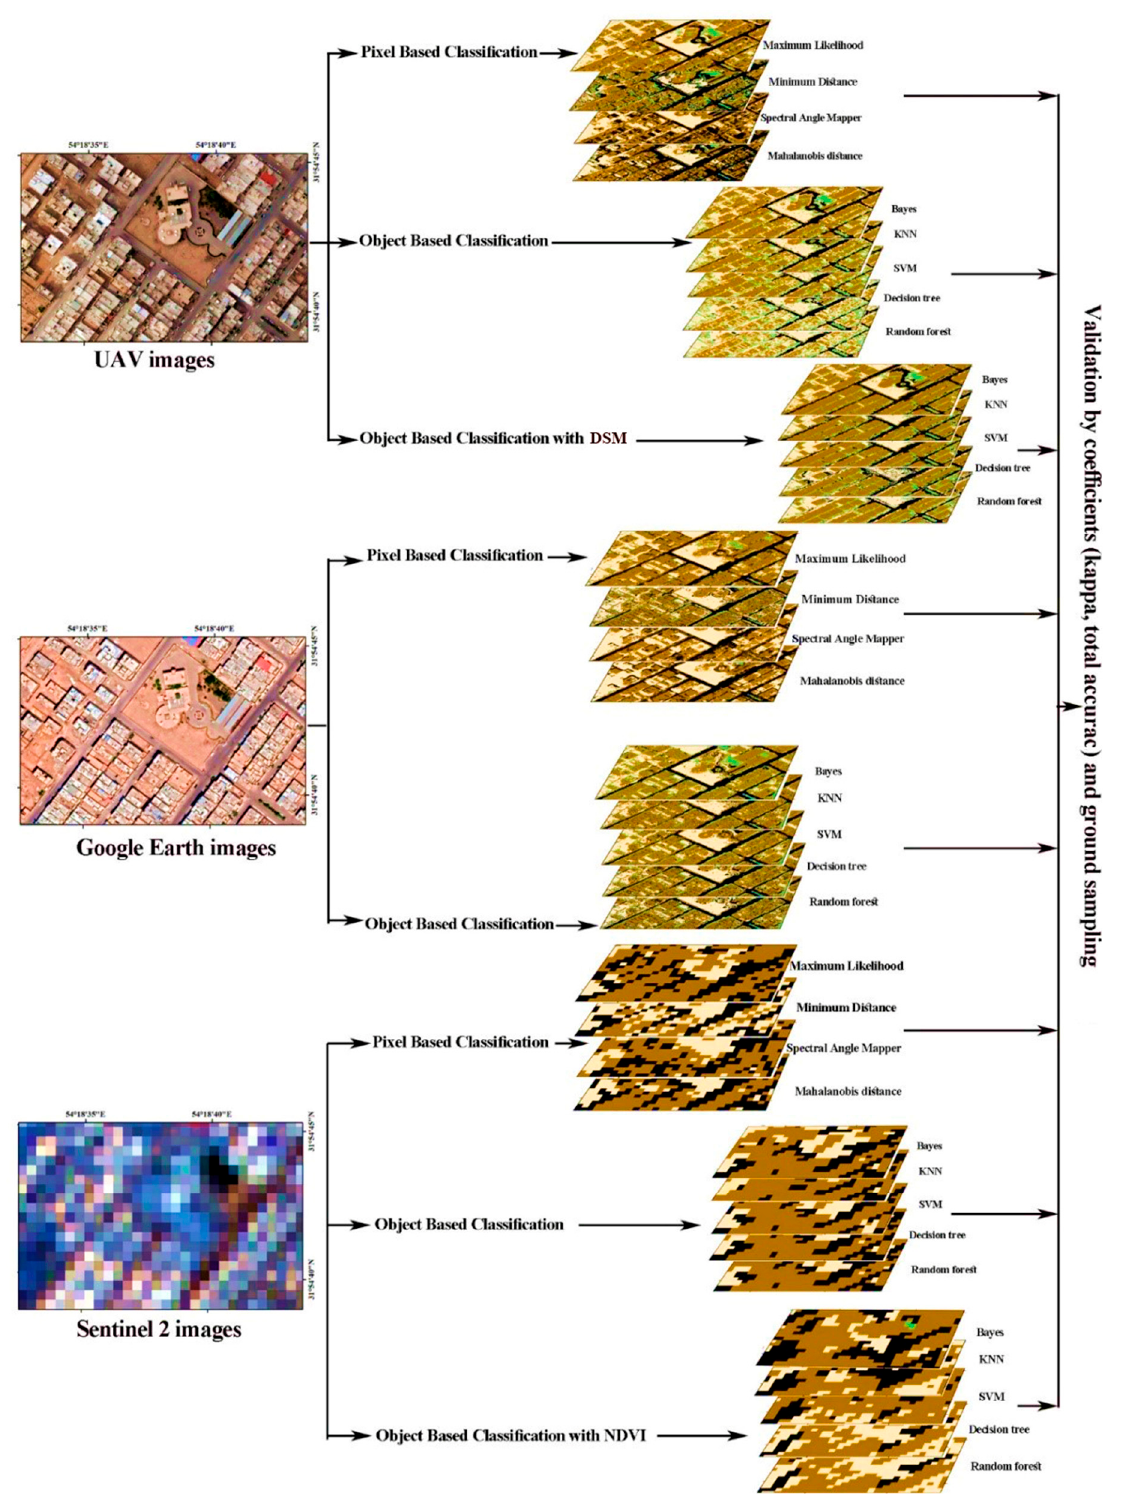
Figure 2. General view of the methodological framework used in this